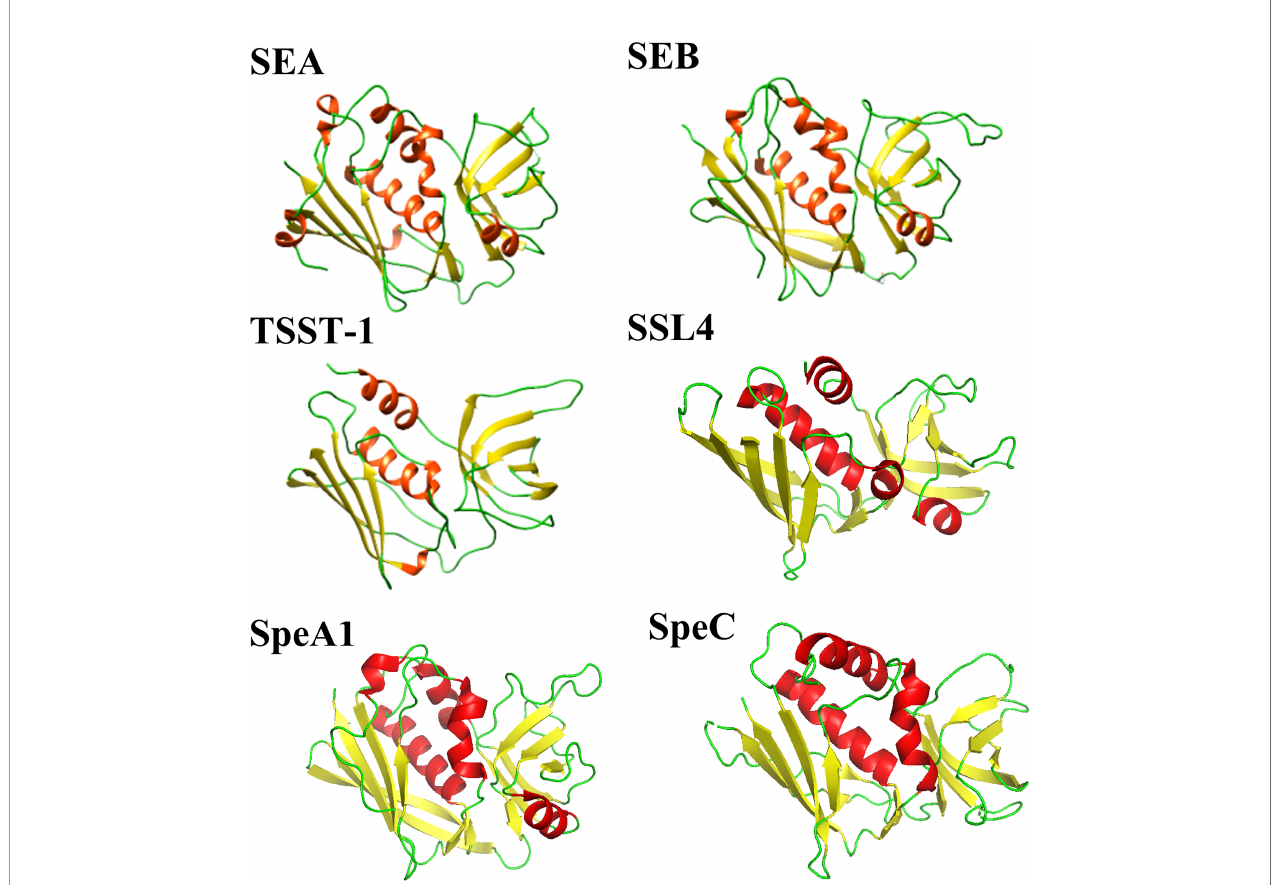
FIGURE 1 | Comparison of selected Staphylococcal aureus and Streptococcus pyogenes enterotoxin and enterotoxin-like structures. Staphylococcal aureus enterotoxins include SEA (PDB code: 1ESF), SEB (PDB code: 1SE4) and TSST-1 (PDB code: 2QIL). The Staphylococcal aureus enterotoxin-like protein shown is SSL4 (PDB code: 4DXF). Two Streptococcal pyogenes enterotoxins are displayed: SpeA1 (PDB code: 1UUP) and SpeC (PDB code: 1KTK). The structures are shown as a ribbon plot with a -helices, b -strands and loops coloured in red, yellow, and green,